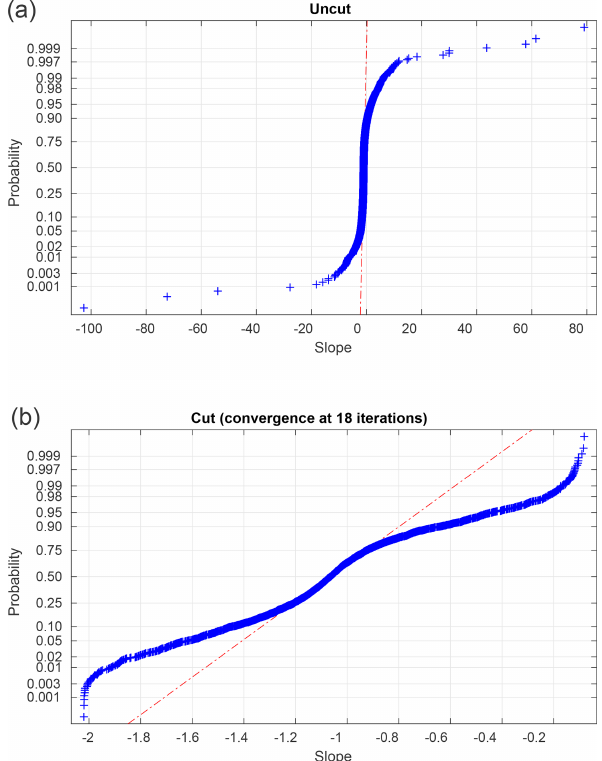
Figure 6. Probability plots of slopes for the entire dataset, before and after a 3 σ iterative cut. The dashed–dotted lines indicate the shape expected for a purely Gaussian distribution. In the interests of clarity, we omit five points with extremely large or small slopes from (a) . See Table 2 for statistical details of these distributions.